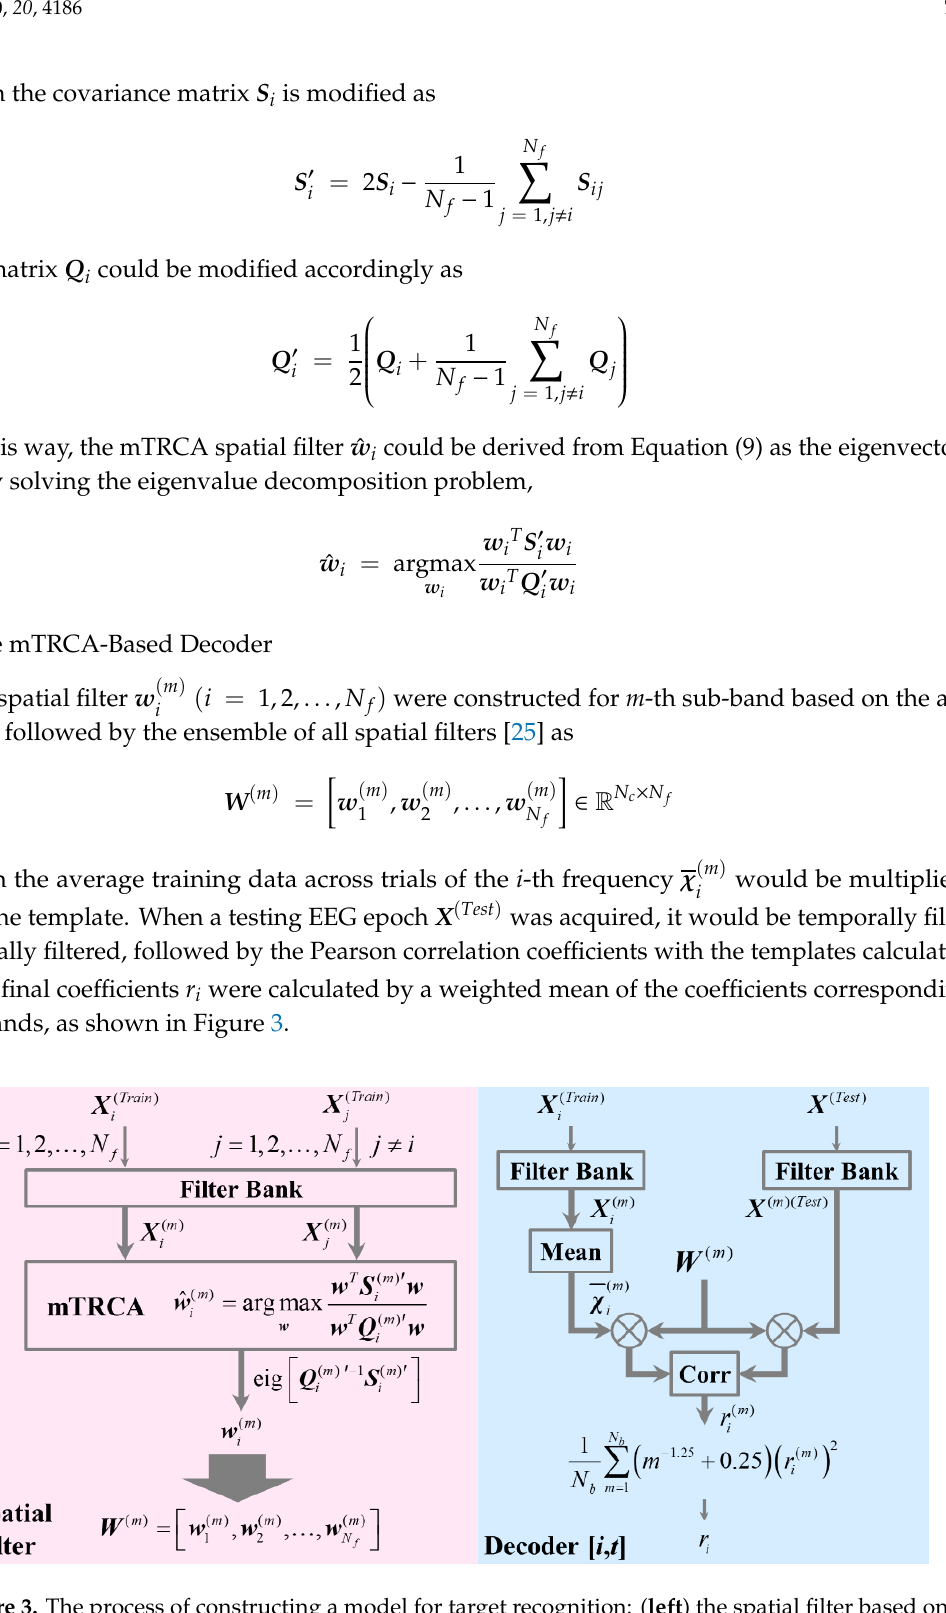
Figure 3. The process of constructing a model for target recognition: ( left ) the spatial filter based on modified task-related component analysis (mTRCA), ( right ) the decoder corresponding to the i -th frequency with data length of t .